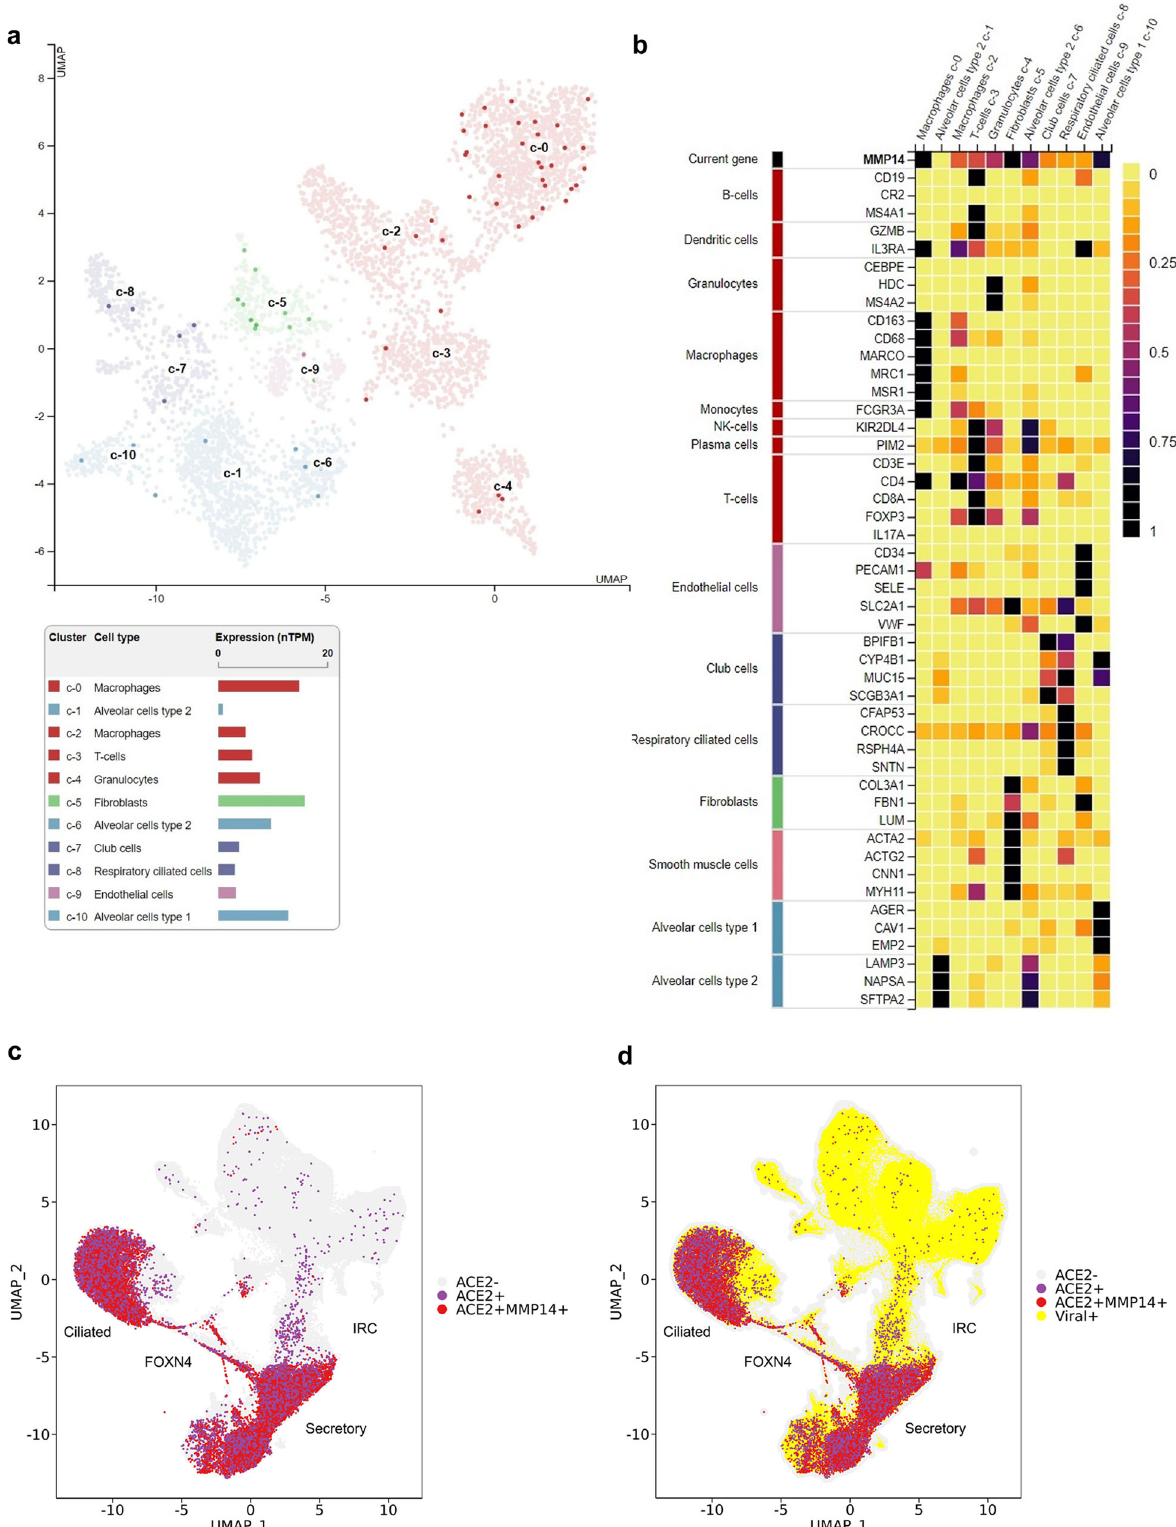
Fig. 2 | MT1-MMP + ACE2 + lung epithelial cells are susceptible to SARS-CoV-2 infection. a MT1-MMP + cells weredistributed across the indicated celltypes in the humanlungwithinUMAP. b Heatmapanalysisof MMP14 geneexpressioninvarious lung and airwaycells. c The distribution of ACE2 + and ACE2 + MT1-MMP + cellsin the